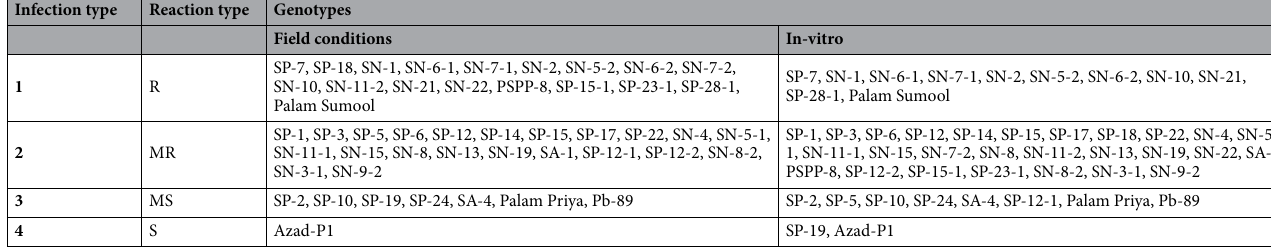
Infection type Reaction type